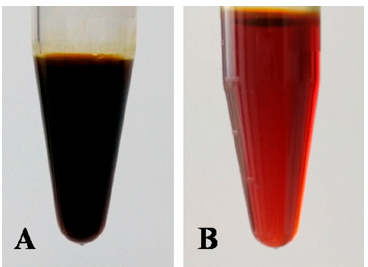
Figure 5. Photos of crude HEO ( A ) and pure HEO ( B ).